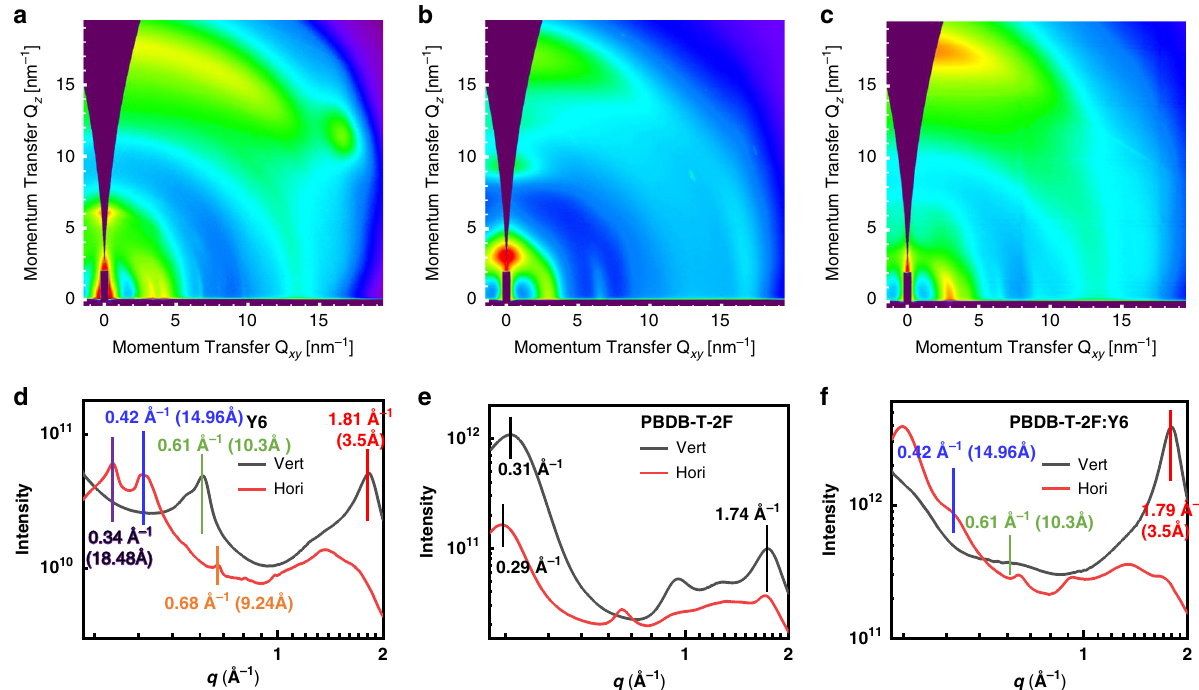
Fig. 2 GIWAXS characterization of Y6 based systems. a – f Two-dimensional GIWAXS patterns (top) and pro fi les (bottom) of a , d the pristine Y6, b , e pristine PBDB-T-2F, and c , f PBDB-T-2F:Y6 fi lms,